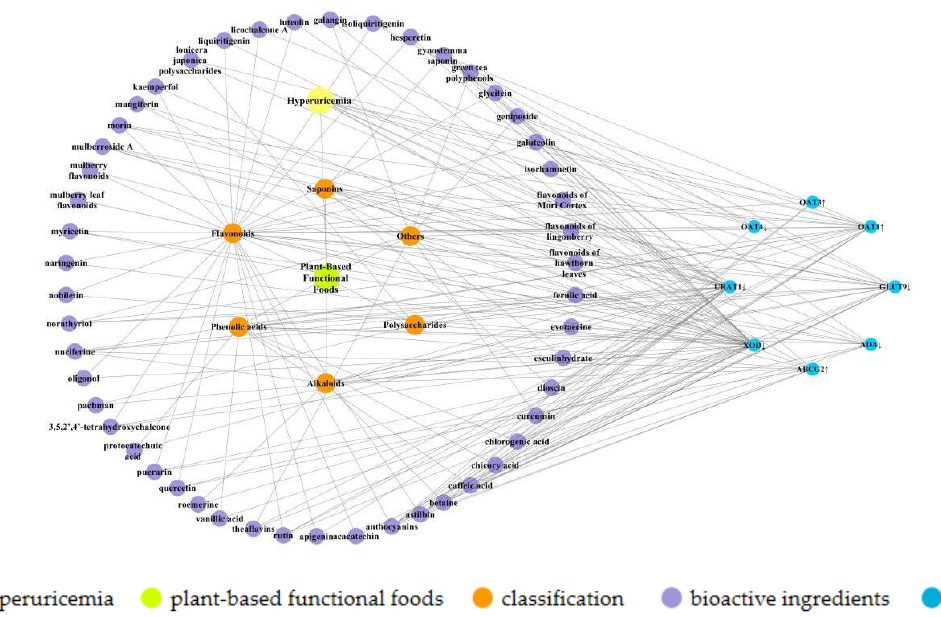
Figure 7. The hypouricemic effects on the compounds–targets network from the plant-based functional foods.